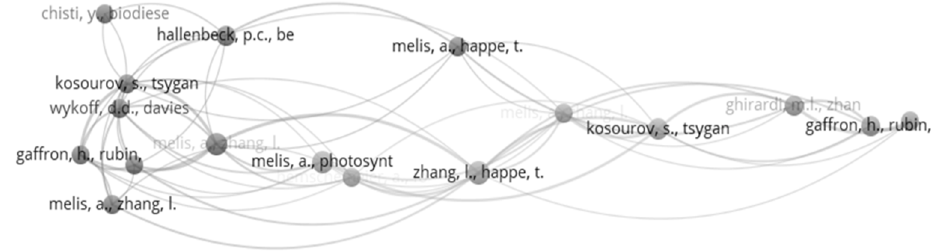
Figure 7. Co-citation network map. (The node size represents the number of citations, and the curved lines show the co-citation ties between the references.)